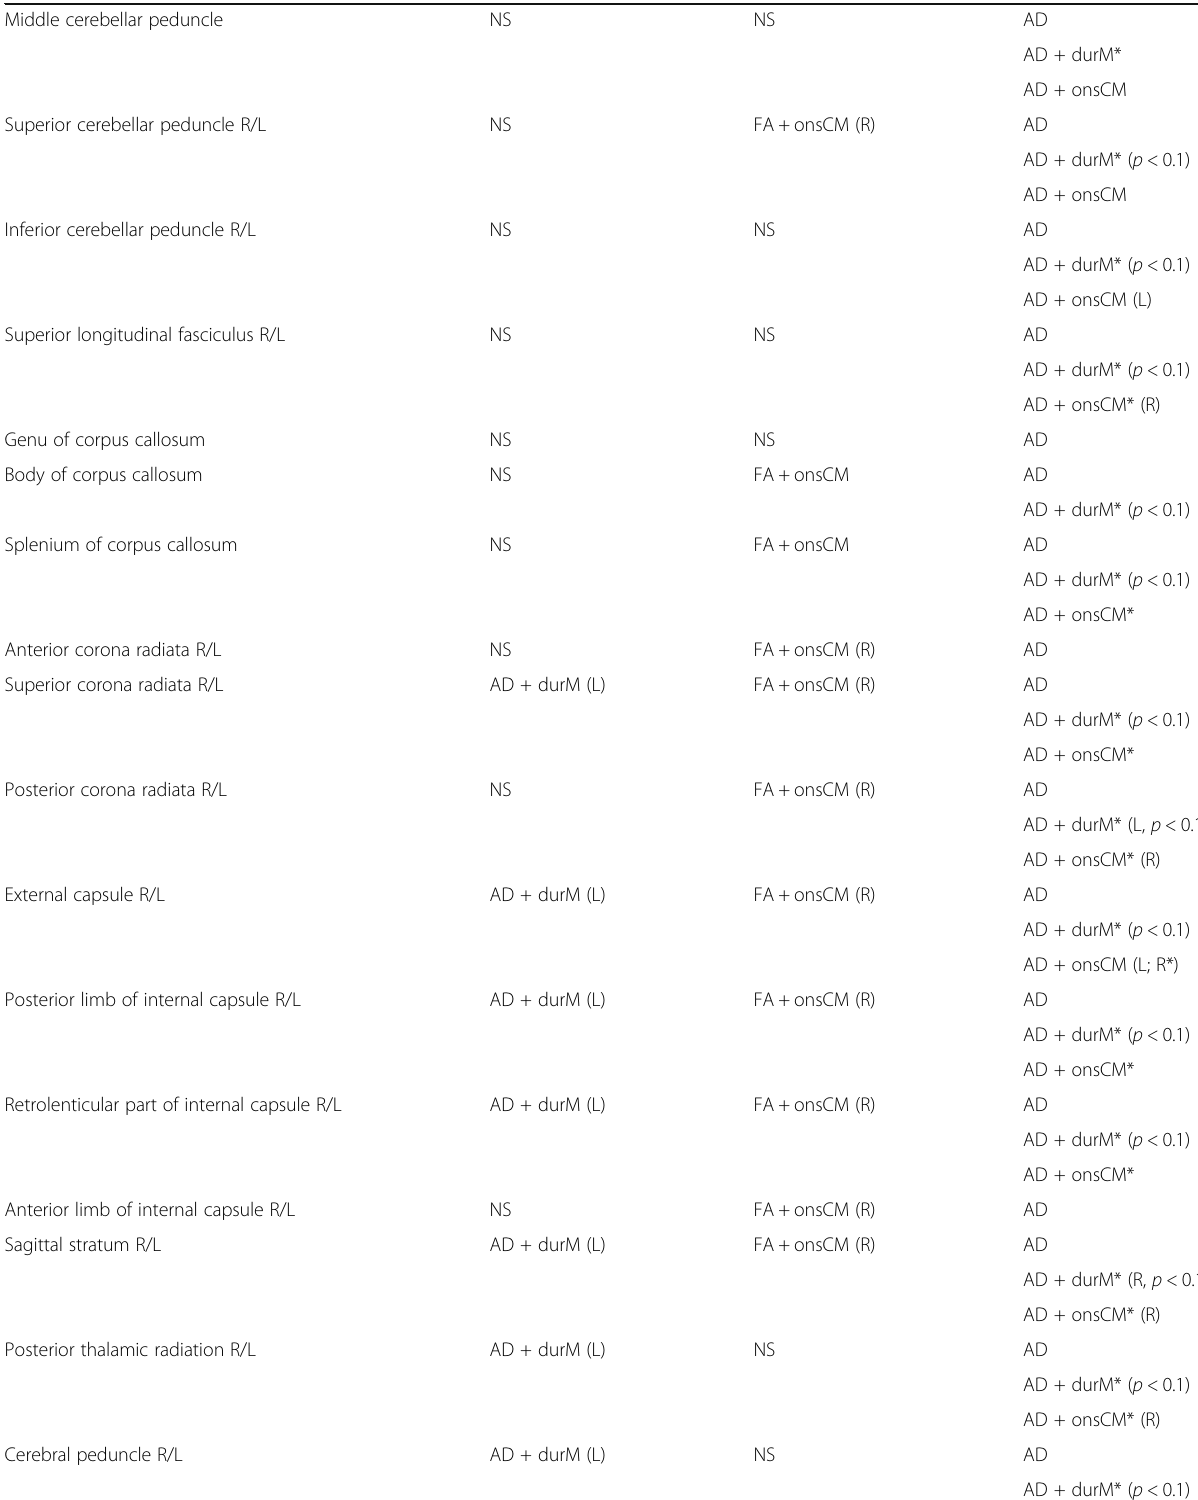
Table 6 Summary of white matter regions where significant differences were found in all comparisons White Matter